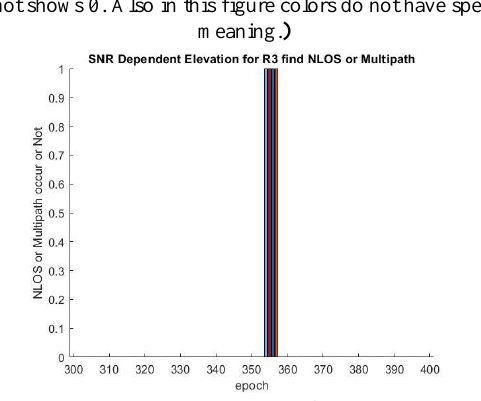
Figure 15. CMCD find NLOS or Multipath for E26 Figure 12. SNR Dependent Elevation find NLOS or Multipath ( In this figure, if multipath or NLOS detected bar shows 1, and for R3 if not shows 0. Also in this figure colors do not have special ( In this figure, if multipath or NLOS detected bar shows 1, and meaning. if not shows 0. Also in this figure colors do not have special meaning. )